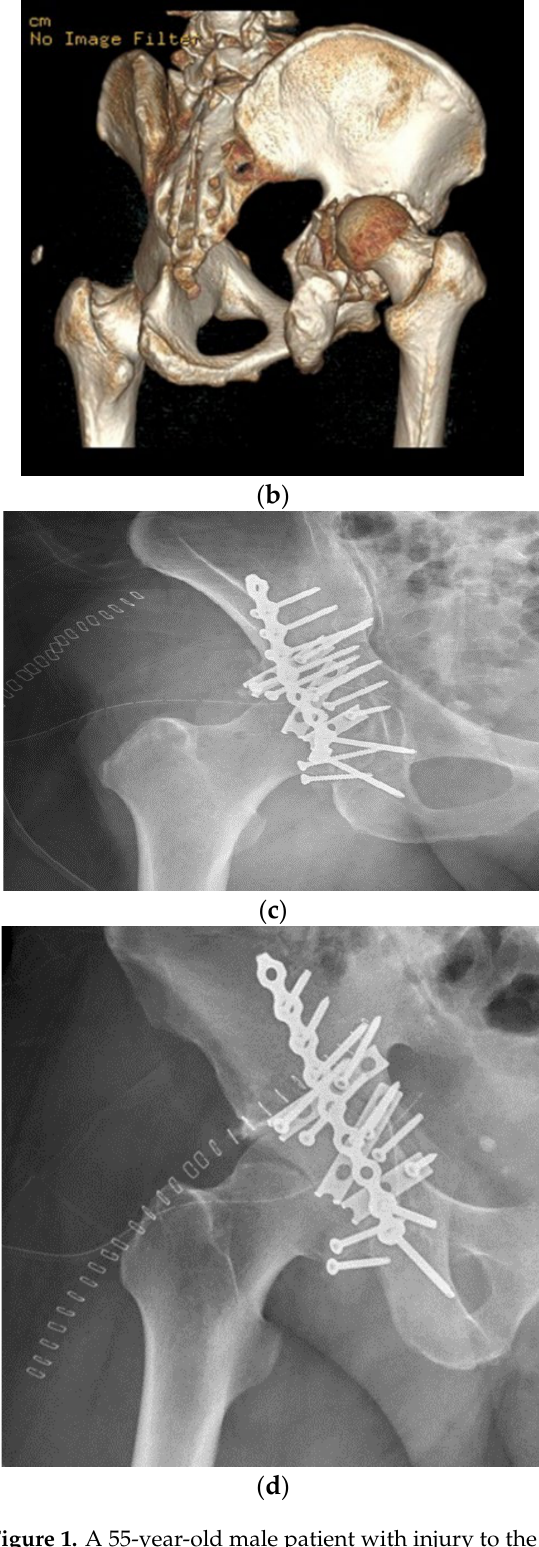
Figure 1. A 55-year-old male patient with injury to the right hip in a traffic accident. Preoperative radiography and CT scan reveal comminuted posterior right acetabular wall fracture